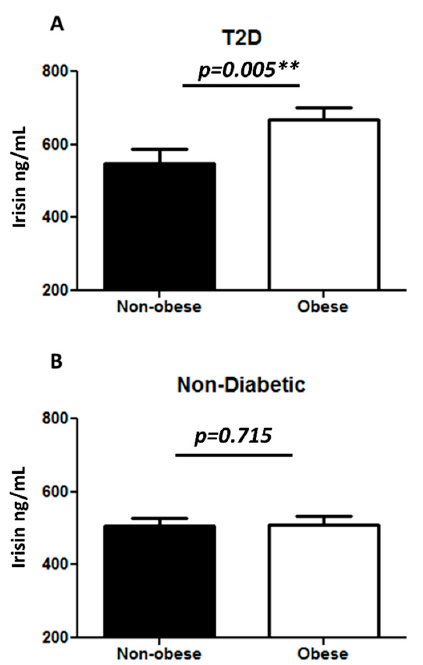
Figure 4. Irisin level in plasma following sub-classification into four groups: non-diabetic non-obese and obese (n = 124) and T2D non-obese and obese (n = 104). ( A ) Comparing the plasma level of irisin in non-diabetic non-obese and obese individuals; ( B ) comparing the plasma level of irisin in T2D non-obese and obese individuals. Irisin level in plasma was determined using enzyme linked immunosorbent assay. The population was classified on the basis of their diabetic status and further sub-classified on the basis of obesity. Diabetes was defined by fasting plasma glucose ≥ 126 mg / L (7 mmol / L). Obesity was defined based on BMI, where participants with BMI > 30 kg / m 2 were considered obese and those with BMI between 20 and 30 kg / m 2 were considered non-obese. Statistical assessment was 2-sided and considered statistically significant at ** p <